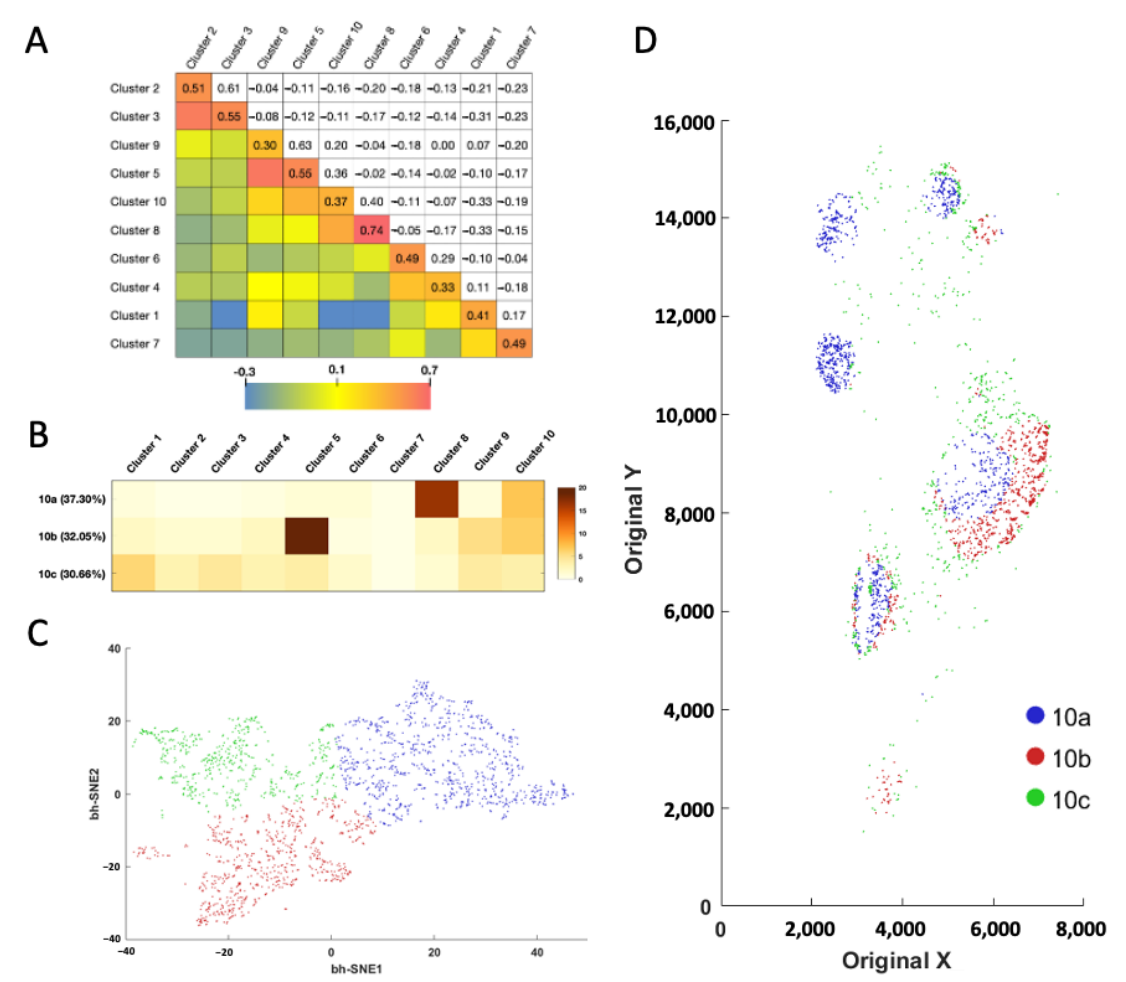
Figure 6. ( A ) Cell cluster to cell cluster interaction strength heatmap. The upper triangle shows the correlation coefficient of the cell numbers in the identified cell neighborhoods. The lower triangle displays the color corresponding to the correlation coefficient. ( B ) Based on their neighbor cells from different clusters, ( C ) the individual cells in cluster 10 are further partitioned into three subclusters. ( D ) Anatomical locations of each cell from the three